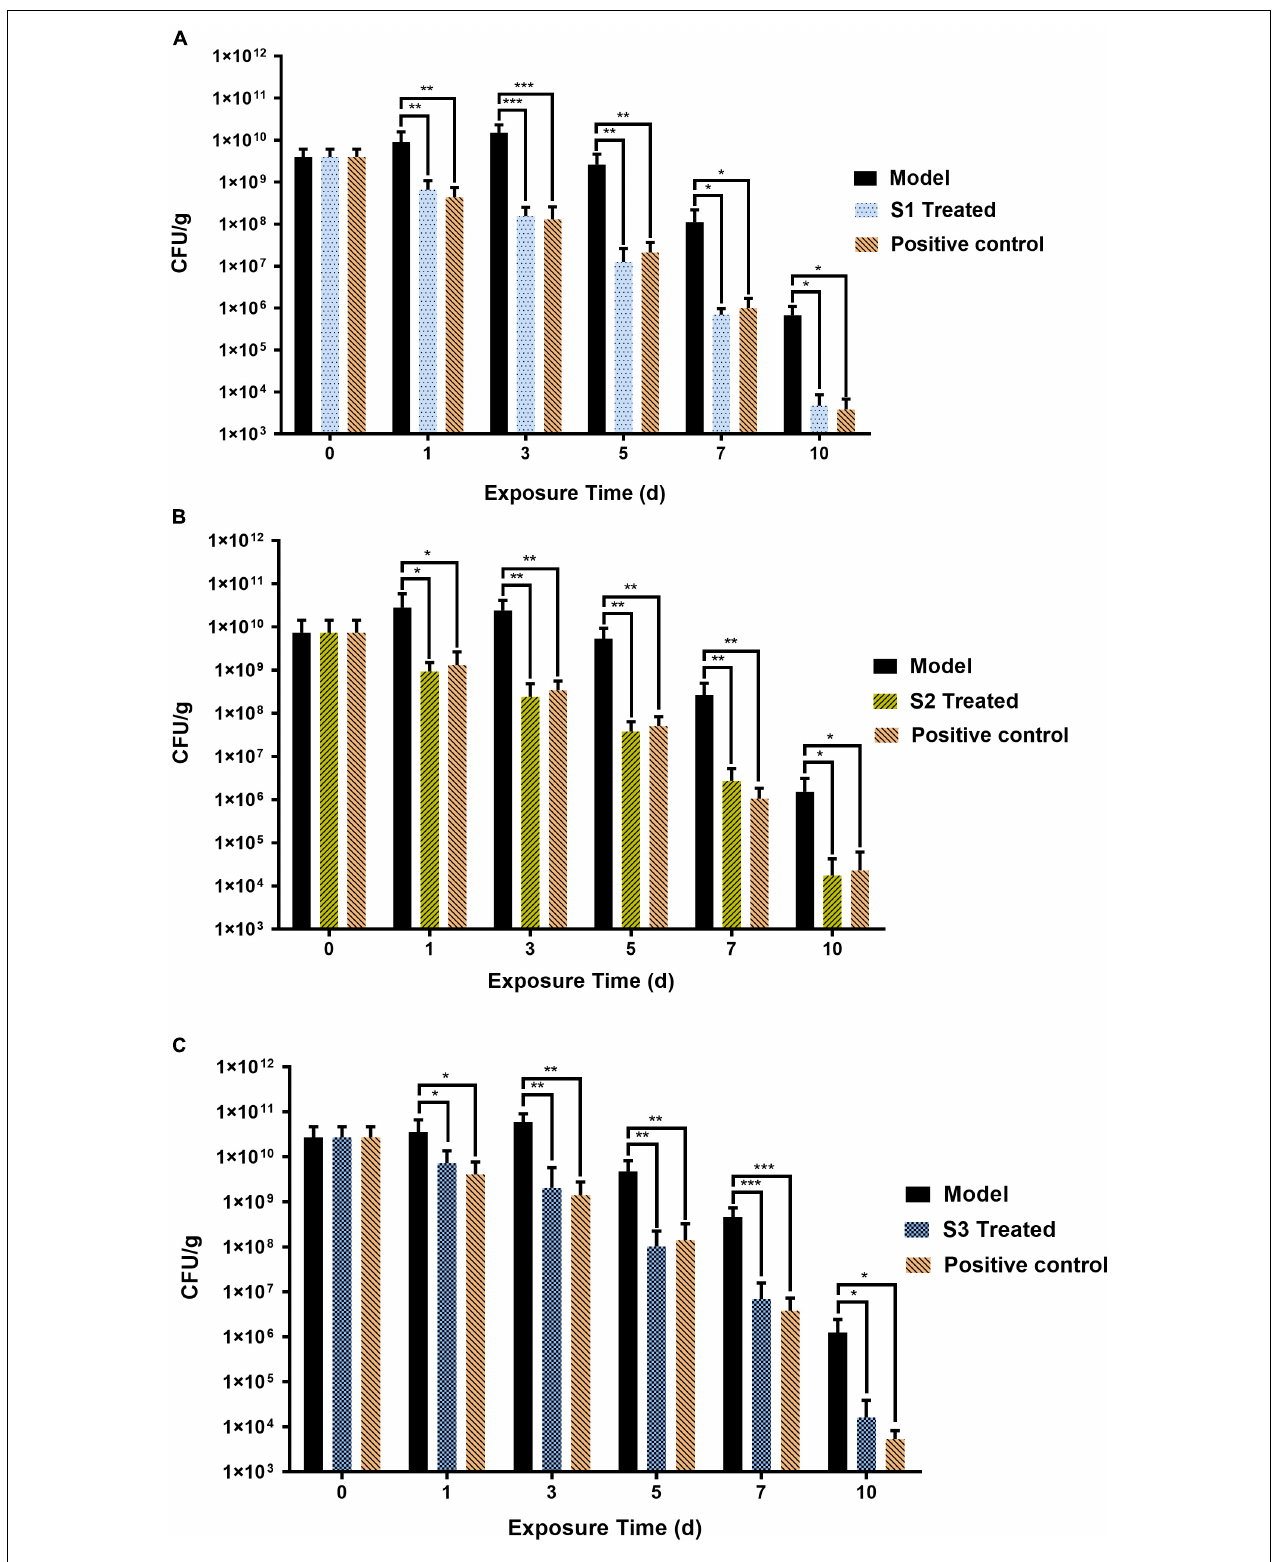
FIGURE 4 | The therapeutic effects of S1, S2, and S3 in mice skin wound infection. Skin wound bacterial burden on days 0, 1, 3, 5, 7, and 10 in mice skin infected by (A) E. coli (CMCC44103), (B) E. coli (SYPB-3820), and (C) S. aureus (CMCC26003). *, **, *** represent p < 0.05, p < 0.01, and p < 0.001, respectively.